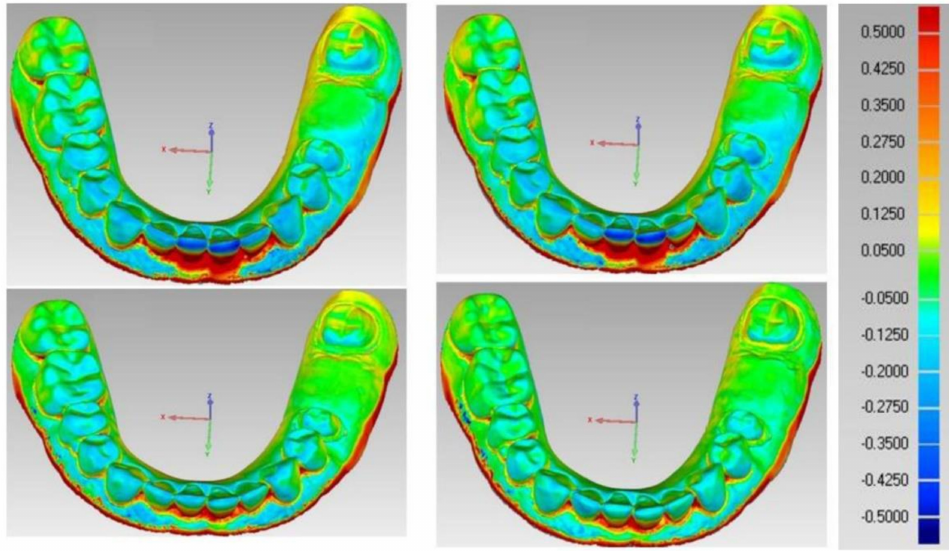
Figure 13. Color map of milled models.